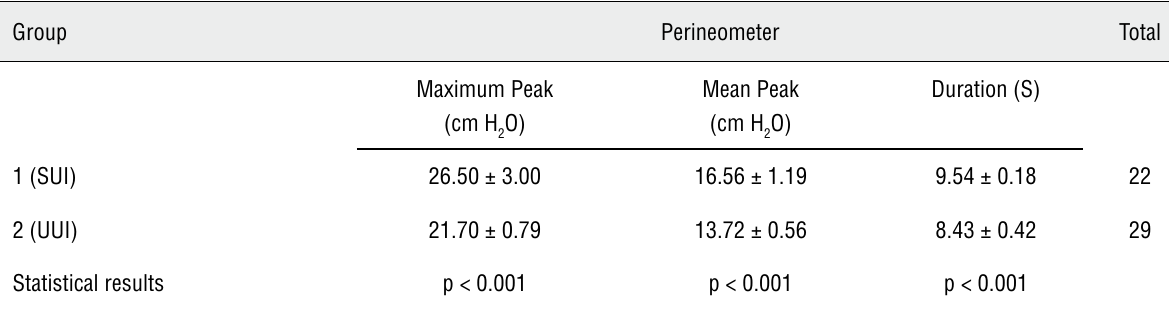
Table 4 - Perineometer evaluation of perineal muscle